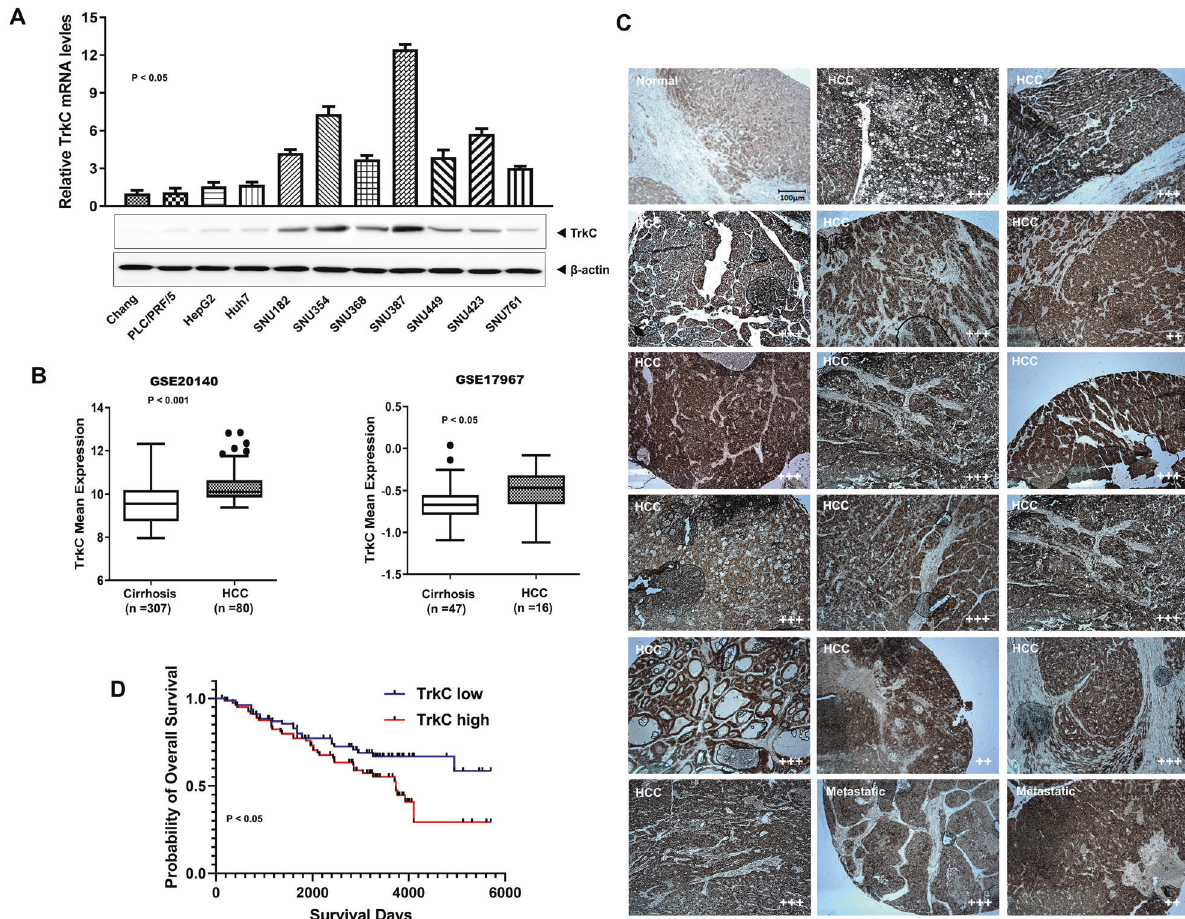
Fig. 1 Upregulated TrkC in HCC is correlated with the pathogenesis of HCC. A The relative mRNA and protein levels of TrkC in human HCC cancer cells. The mRNA and protein levels of TrkC were normalized to the 18S mRNA and β -actin, respectively. n = 3. P < 0.05, t -test. B The mRNA levels of TrkC in cirrhosis and HCC patients from the GSE20140 and GSE17967. n = 3. P < 0.05, t -test. C The immunohistochemistry analysis of normal, HCC, and metastatic HCC patients for the TrkC expression (magni fi cation: 200×). The immunohistochemistry intensity of HCC or metastatic HCC was estimated by normal liver tissue, and the staining intensity was scored with grades + ~ +++ . D Kaplan-Meier analysis of overall survival of HCC patients between high or low TrkC expression. The average expression value of TrkC was determined from GSE20140, rank-ordered, and then divided into two equal groups. P < 0.05 (*); log-rank